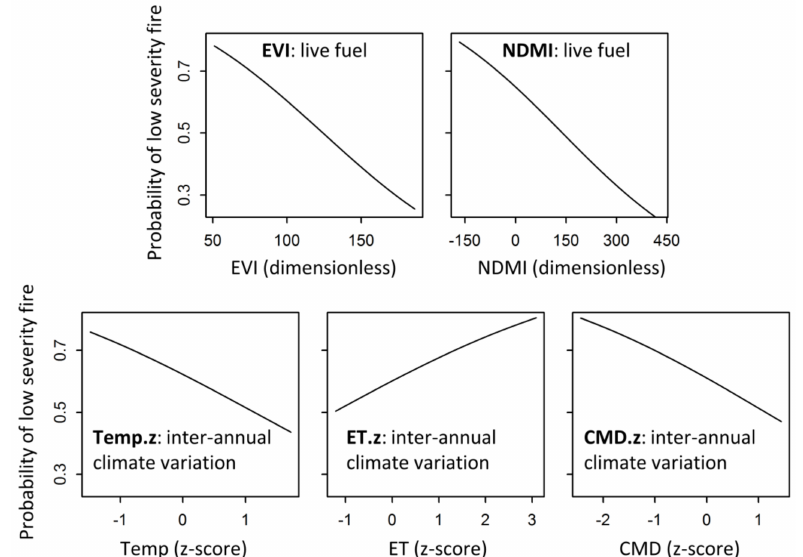
Figure 3. Functional relationships depict the probability of low-severity fire as a function of live fuels and inter-annual climate variation. Each of these was produced with a logistic regression with only the variable of interest. EVI: enhanced vegetation index; NDMI: normalized differenced moisture index; Temp.z: temperature z -score; ET.z: evapotranspiration z -score; CMD.z: climatic moisture deficit z -score. Functional relationships for TPI, SRAD, and ET are not shown since the relative influence of these variables is less than